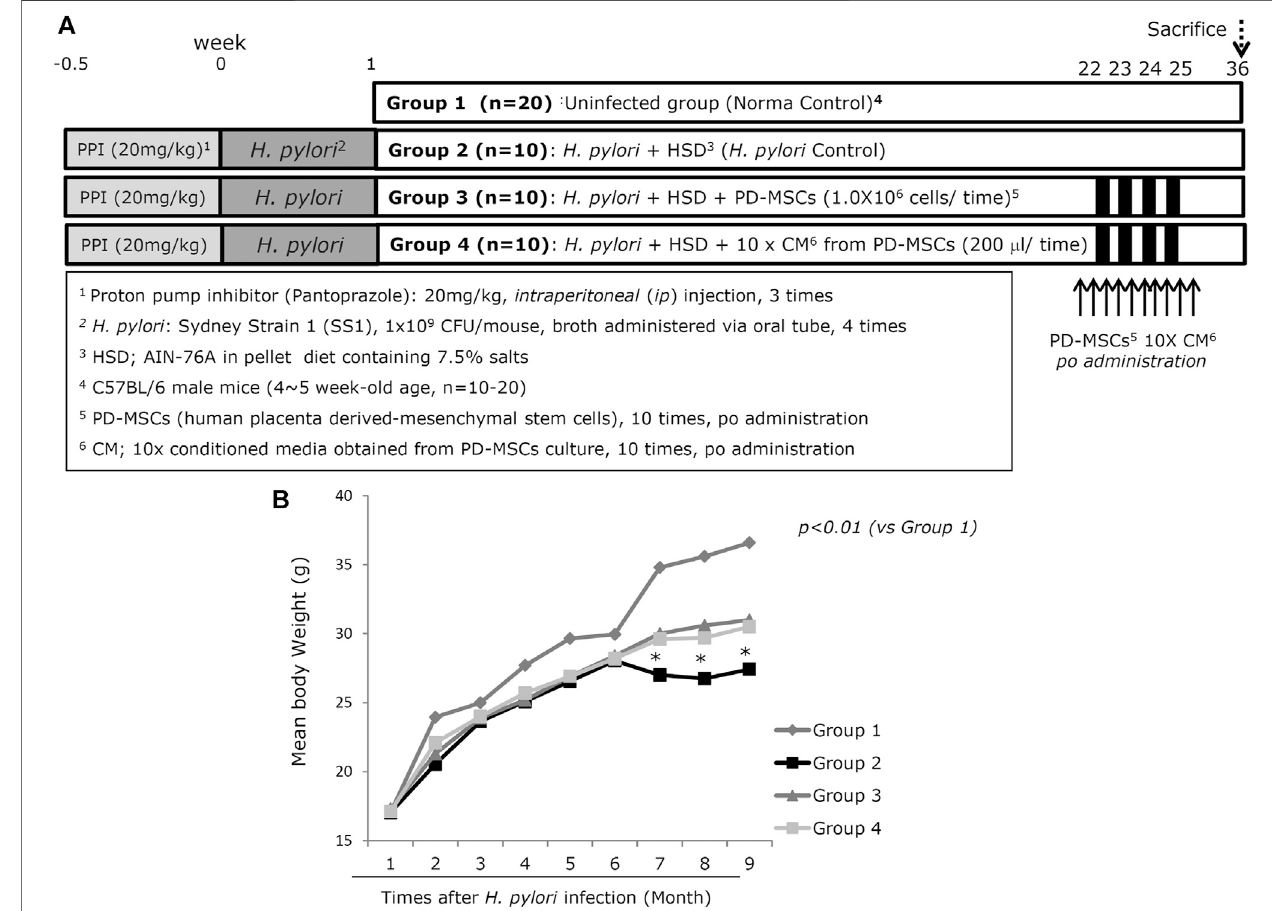
FIGURE 1 | In fl uence of PD-MSCs or their CM on an H. pylori – initiated, high-salt diet – promoted CAG mice model (36 weeks). (A) Scheme for groups: Group 1, normal control; Group 2, H. pylori – associated CAG disease control; Group 3, disease control treated with 1x10 6 PD-MSCs (100 μ l), 10 times during 22 – 25 weeks; and Group 4, disease control treated with 10x concentrated CM (200 μ l). (B) Body weight changes according to groups. Body weights were measured every 3 days in all mice. (C) Representativephotooftheresected stomachandmeangrosslesionscoresaccordingtogroups,see Supplementary Table1 forthescoringsystem. (D) Representationalpathology and mean pathological scoresaccording to groups, see Supplementary Table 2 forthe scoring system. All data represent mean ± SD ( n (cid:1) 10).